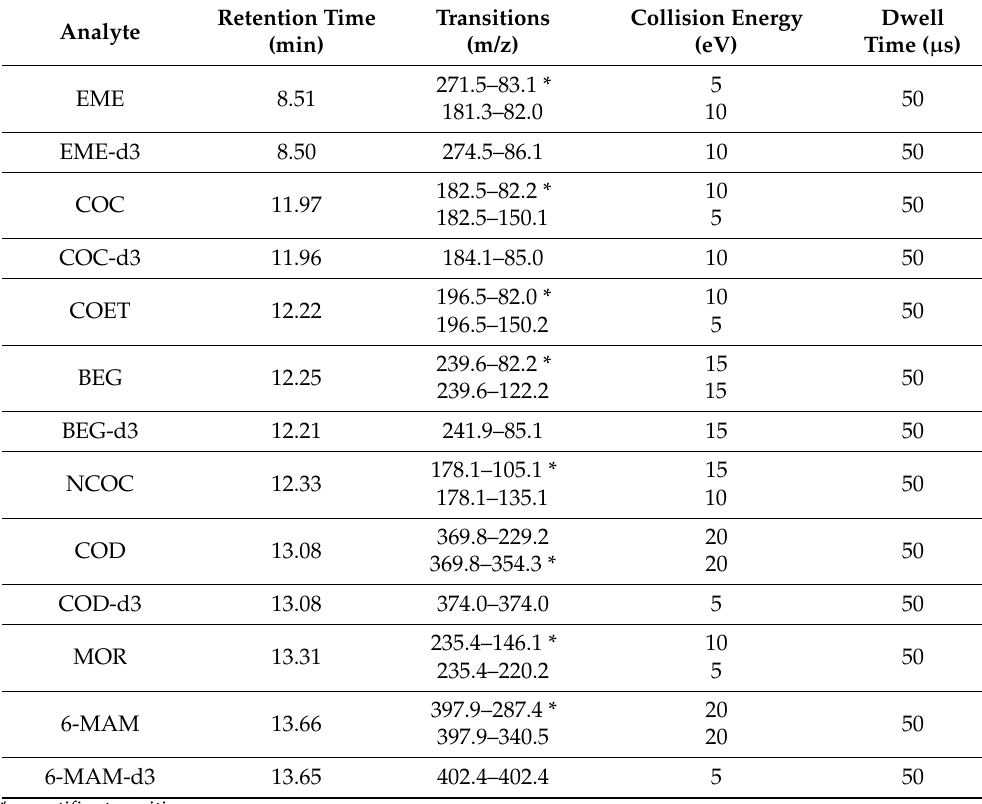
Table 5. Retention times and selected transitions for the identification of